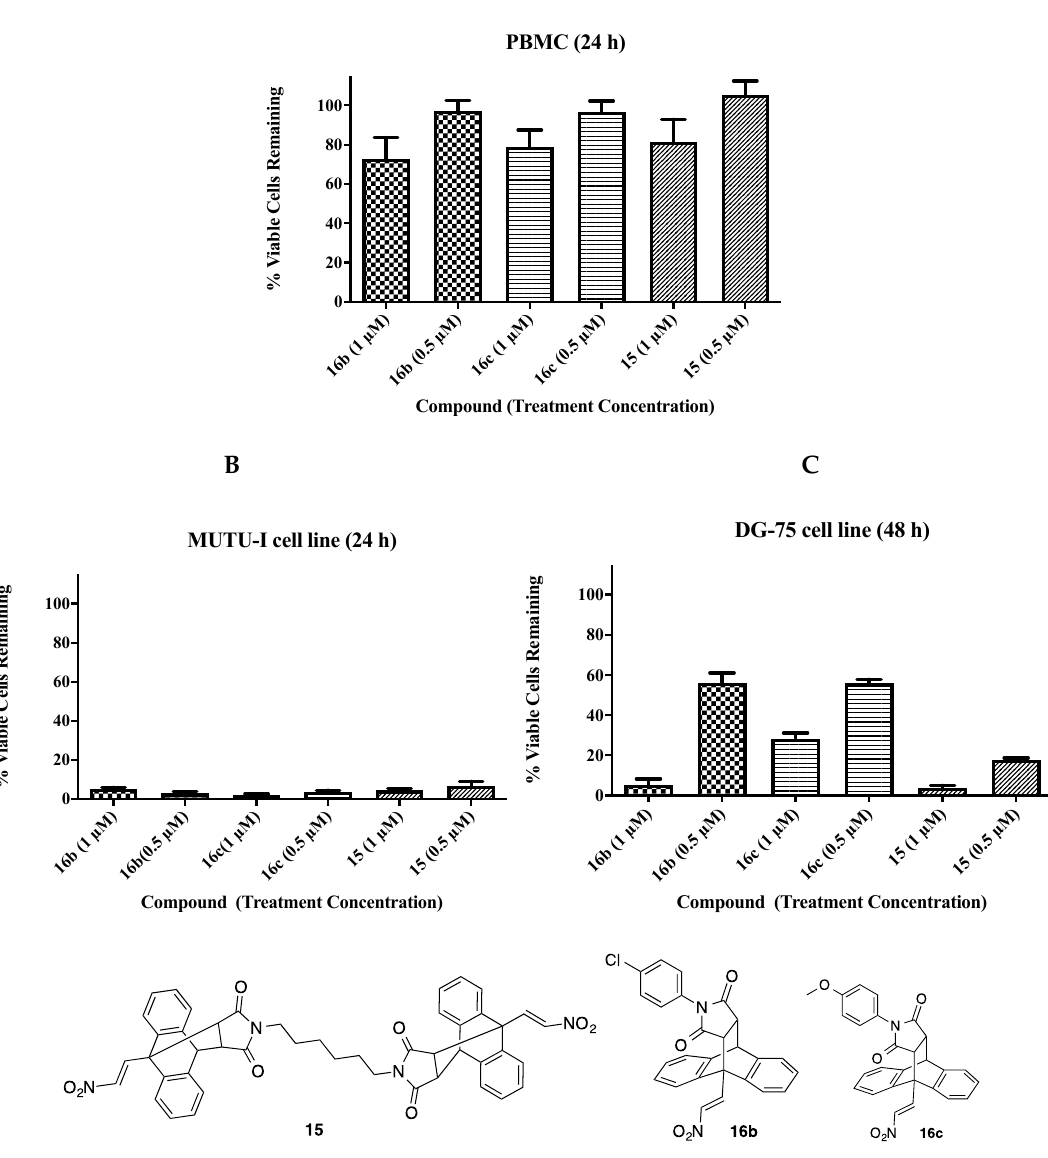
Figure 7. In Vitro antiproliferative effect of compounds 15 , 16b and 16c on ( A ) PBMCs (24 h), ( B ) Figure7. InVitroantiproliferativee ff ectof compounds 15 , 16b and 16c on( A )PBMCs (24h), ( B )MUTU-1 MUTU-1 cell line (24 h) and ( C ) DG-75 cell line (48 h) at 1 μ M and 0.5 μ M. cell line (24 h) and ( C ) DG-75 cell line (48 h) at 1 µ M and 0.5 µ Cell proliferation of MUTU-1 and DG-75 cells was determined with an alamarBlue assay μ M or 0.5 μ M for 24 h (MUTU-1) or 48 h (DG-75) were used to treat the cells (in triplicate) with control